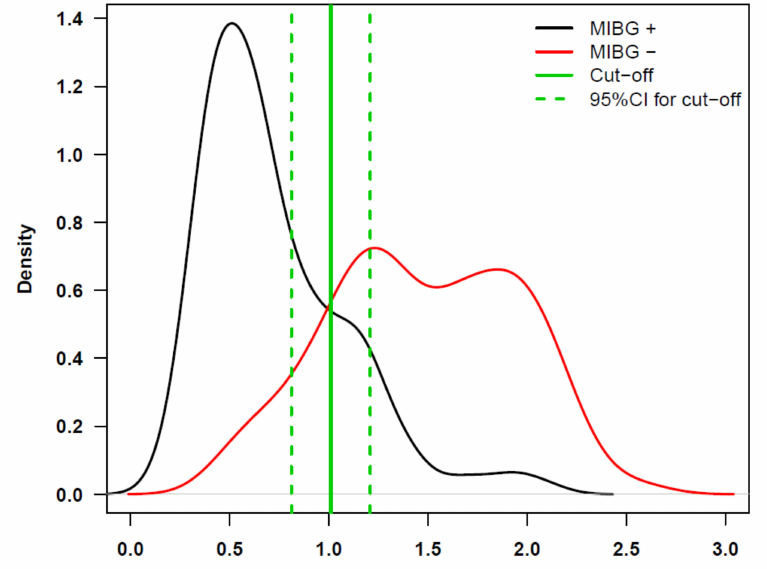
Figure 1. ADC in MRI+